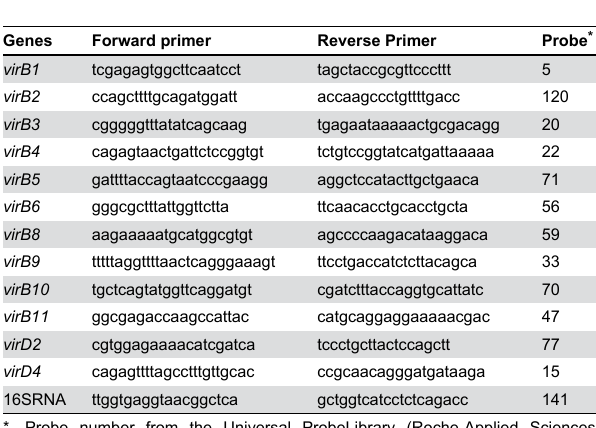
Table 2. Primers and probes used for the T4SS gene expression